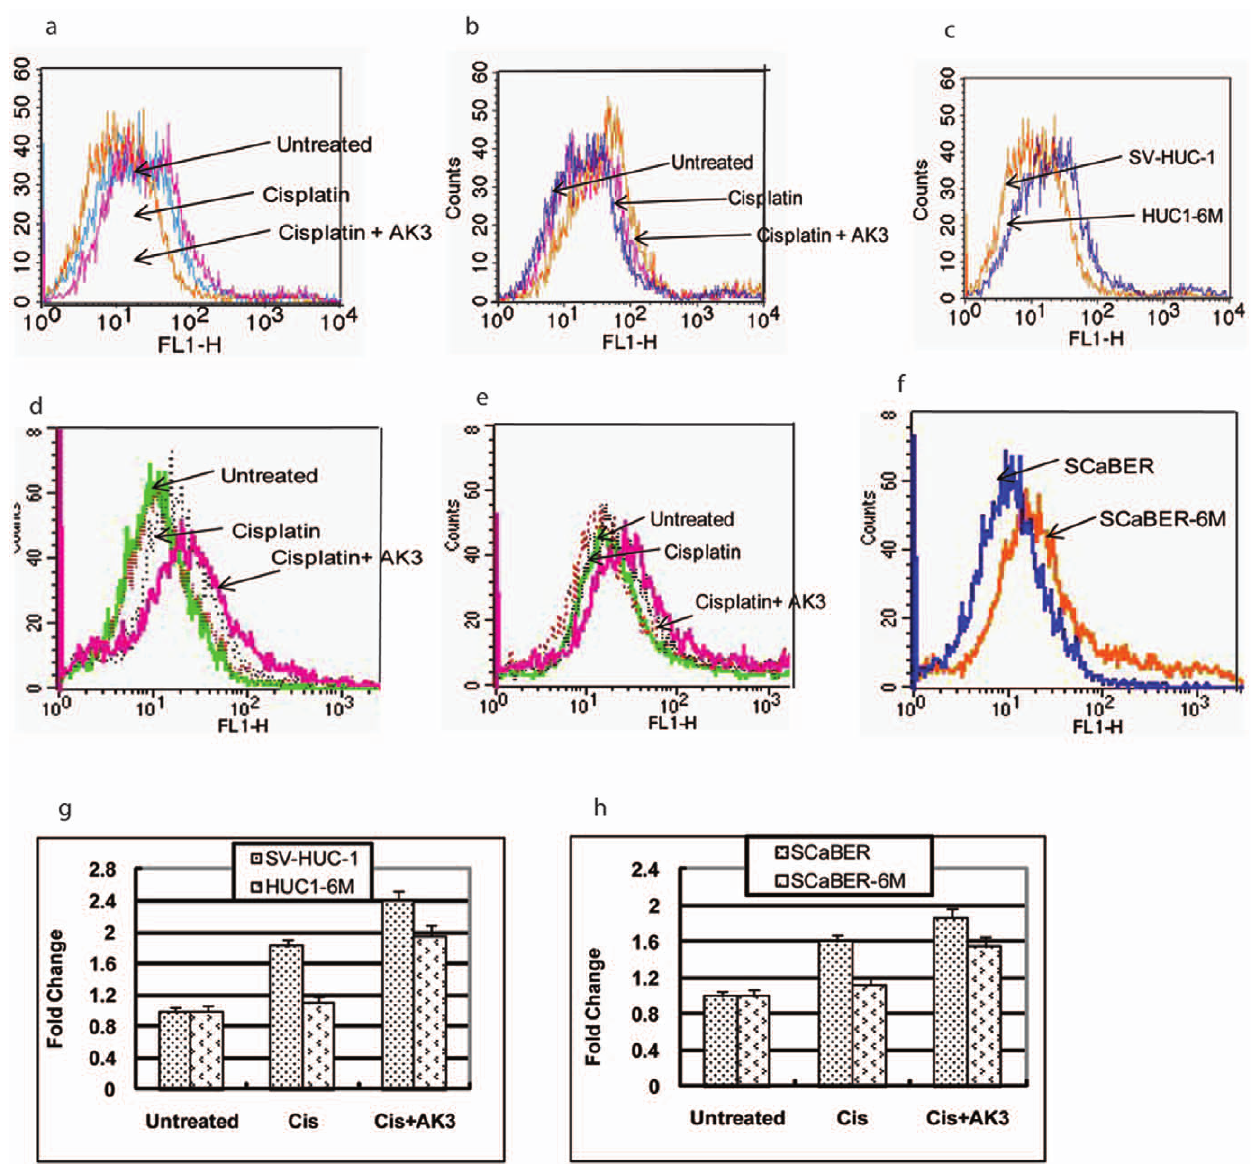
Figure 3. ROS Production by AK3 in the Presence of Cisplatin. ROS production was measured in parental SV-HUC-1 and SCaBER cells or cells exposed to CSC vapor for 6 months using DCFH-DA staining. The cells were transfected with or without the AK3 expression plasmid and treated with or without cisplatin for 48 h before staining. ROS generation in SV-HUC-1 and HUC1-6M (a–c) and SCaBER and SCaBER-6M (d–f) cells with overexpression of AK3 with and without cisplatin. The mean fluorescence density was calculated and data was plotted as mean 6 SD